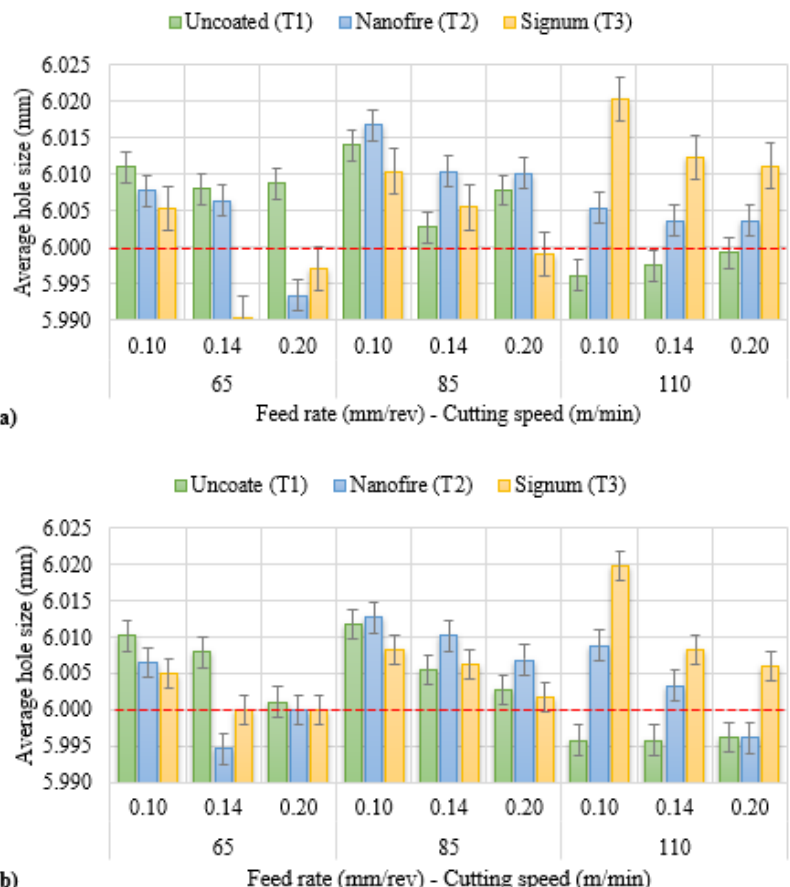
Figure 5. Effect of machining parameters on hole diameter values: a) Hole top surface (HT), b) Hole bottom surface